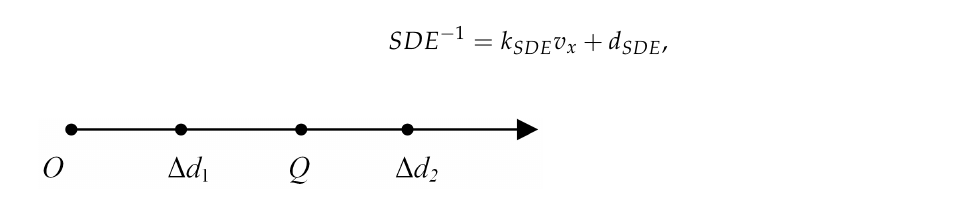
Figure 5. Sideslip angle phase plane division region.